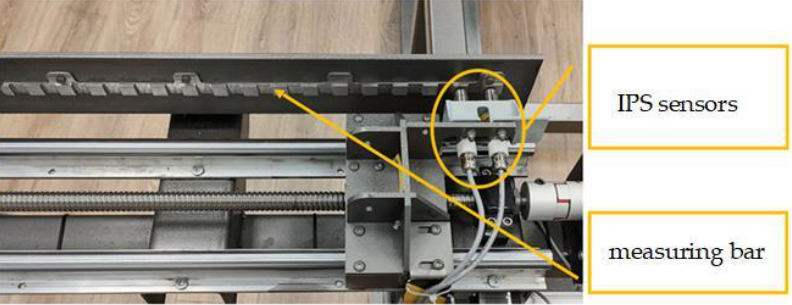
Figure 10. Location of the IPS sensors and measuring bar on the flap simulator.